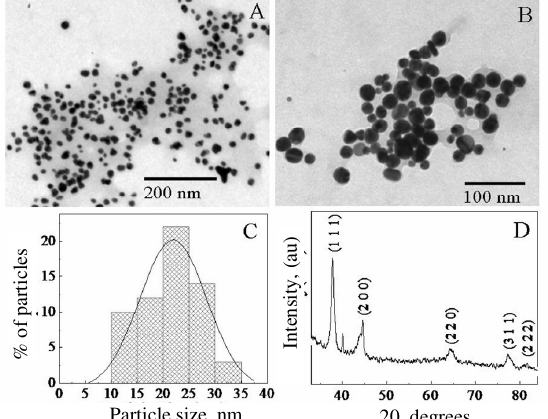
Figure 2. Representative TEM images of TC leaf extract-reduced gold nanoparticles at low magnification (A) and at higher magnification (B). The lower panels in the image (A) shows the corresponding particle size distribution histograms (C). The solid lines in the lower panels is Gaussian fits to the histogram. (D) XRD pattern of a solution-cast film of the TC leaf extract-reduced gold nanotriangles deposited on a glass substrate. The Bragg reflections are identified in the XRD